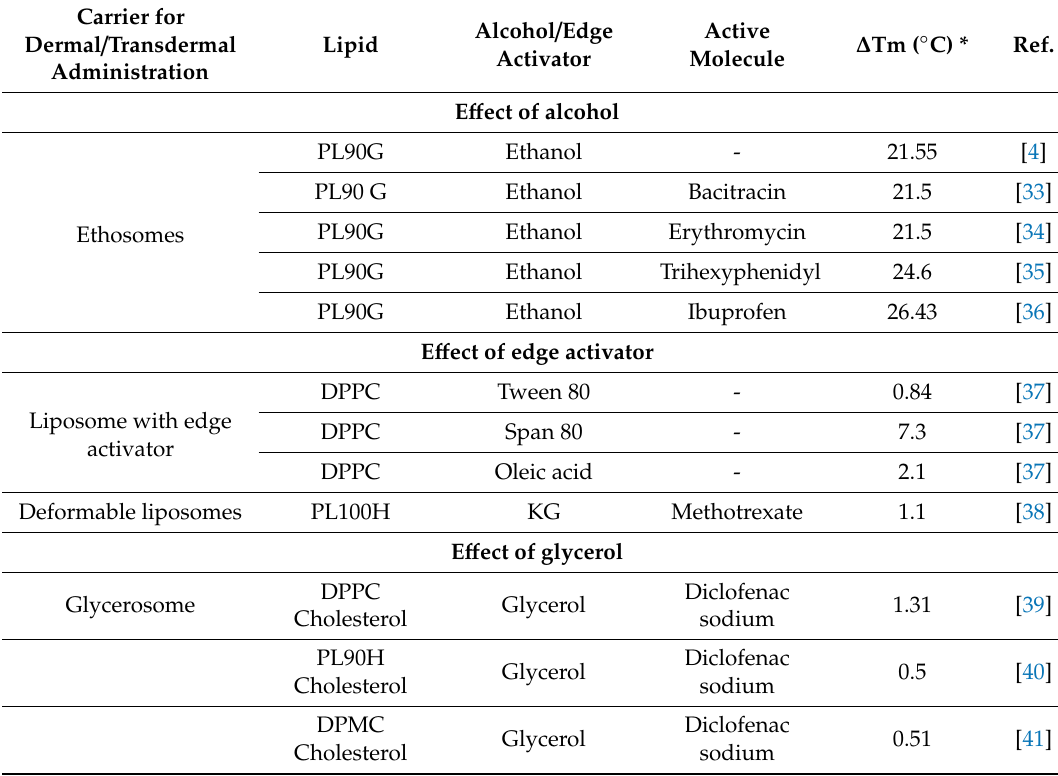
Table 1. The e ff ect of ethanol, edge activator and glycerol on the Tm of phospholipid in various vesicular carriers for dermal / transdermal